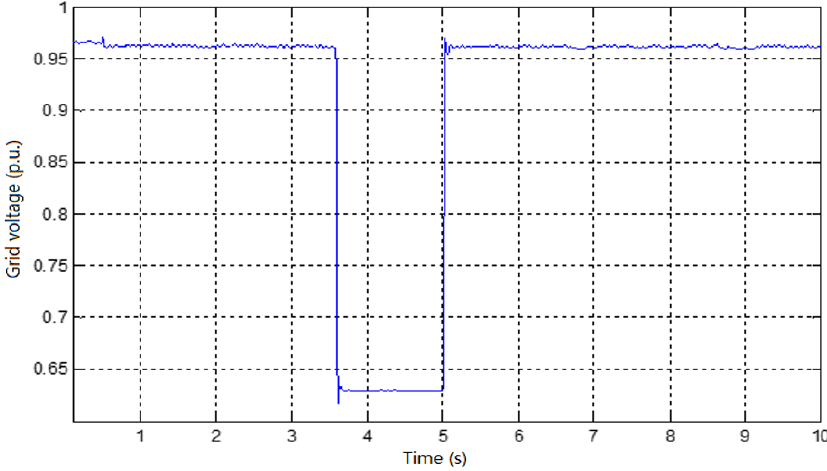
Figure 13. Grid voltage curve with large disturbance of grid voltage.